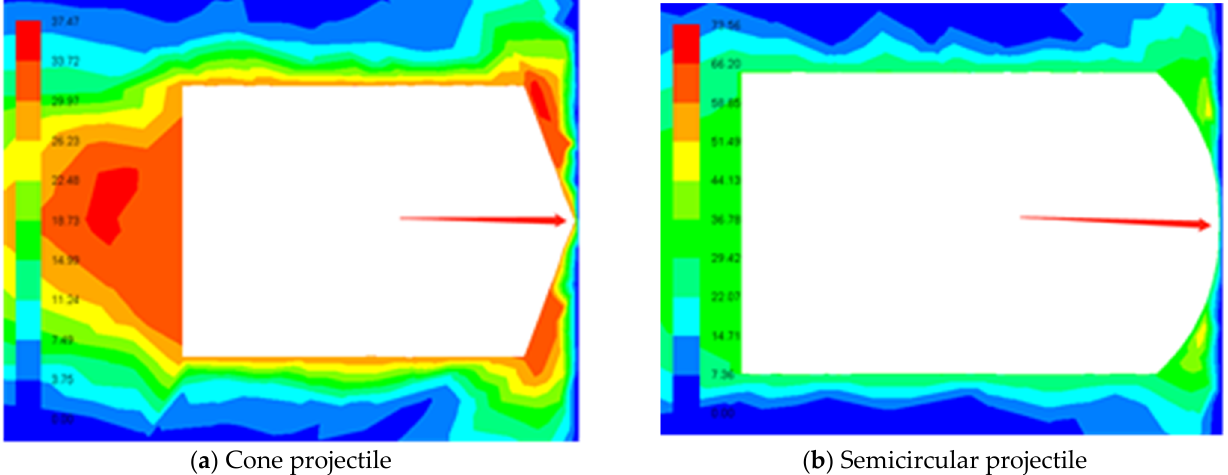
Figure 8. Velocity distribution of the two different front-surface projectile impact states: ( a ) cone projectile and ( b ) Semicircular projectile, at 30 m/s.